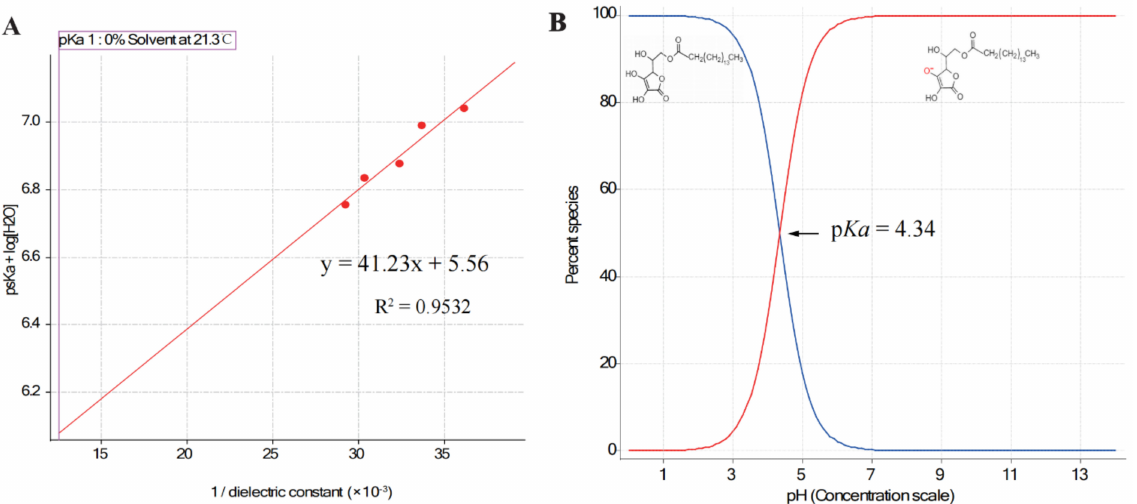
Figure 3. ( A ) The Yasuda–Shedlovsky curve extrapolated by fitting the p s K a test values ( n = 5); ( B ) distribution of species of AsP, an acid with p K a = 4.34.